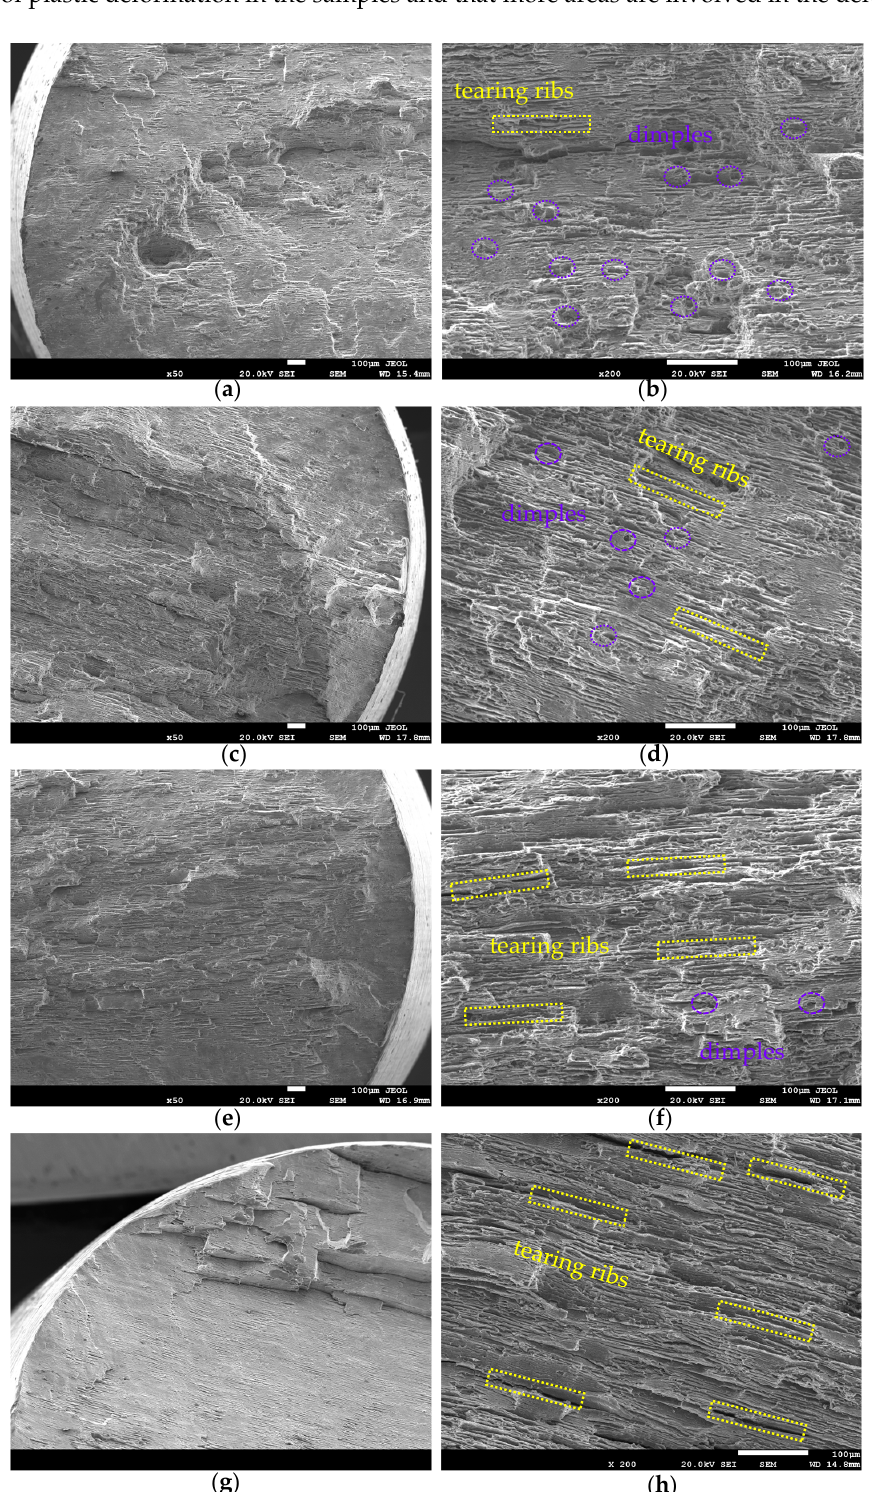
Figure 4. Fracture surface morphologies of 2195-T8 at di ff erent temperatures: ( a , b ) 298 K; ( c , d ) 213 K; ( e , f ) 113 K; and ( g , h ) 20 K.